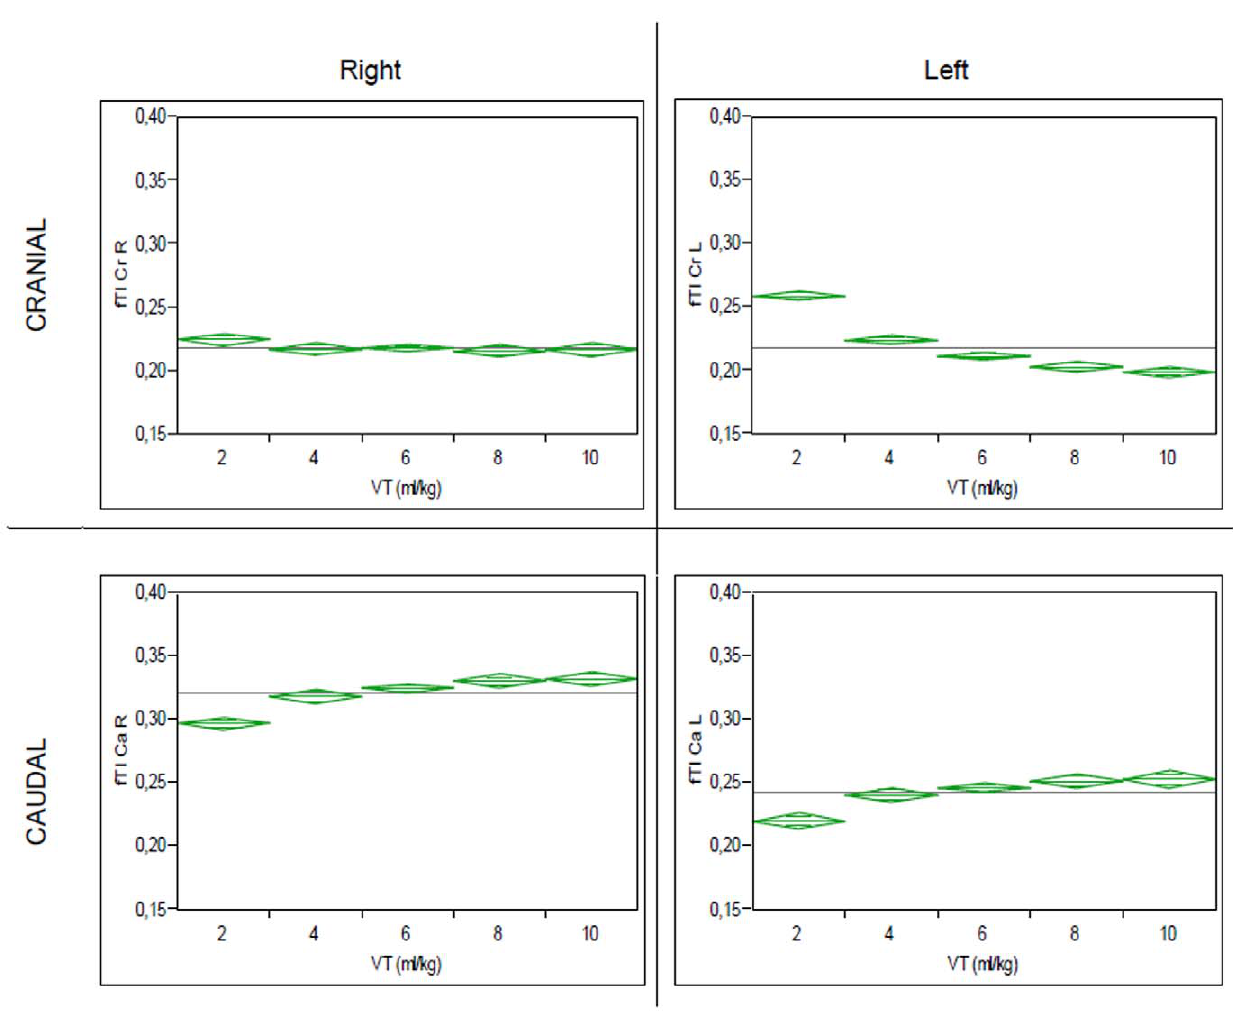
Figure 6. Distribution of fTI in different quadrants at different VT, pre-lavage. Shown are mean (grey line) fTI values for different VT, with 95%-Confidence Interval of the mean (green diamonds).